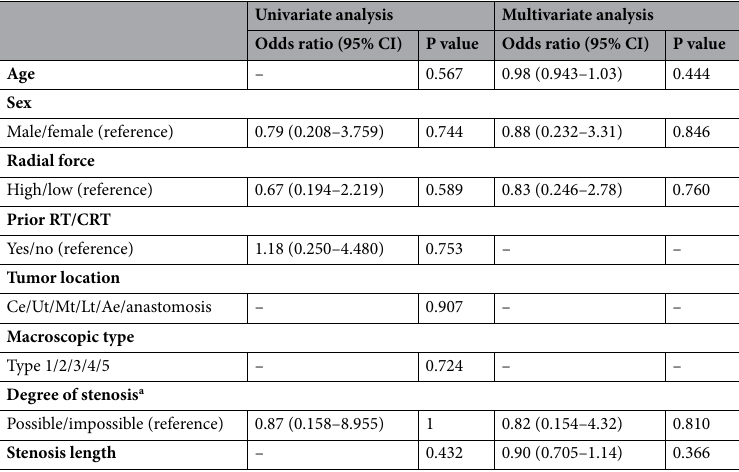
Low radial force group 35 cases in 31 patients